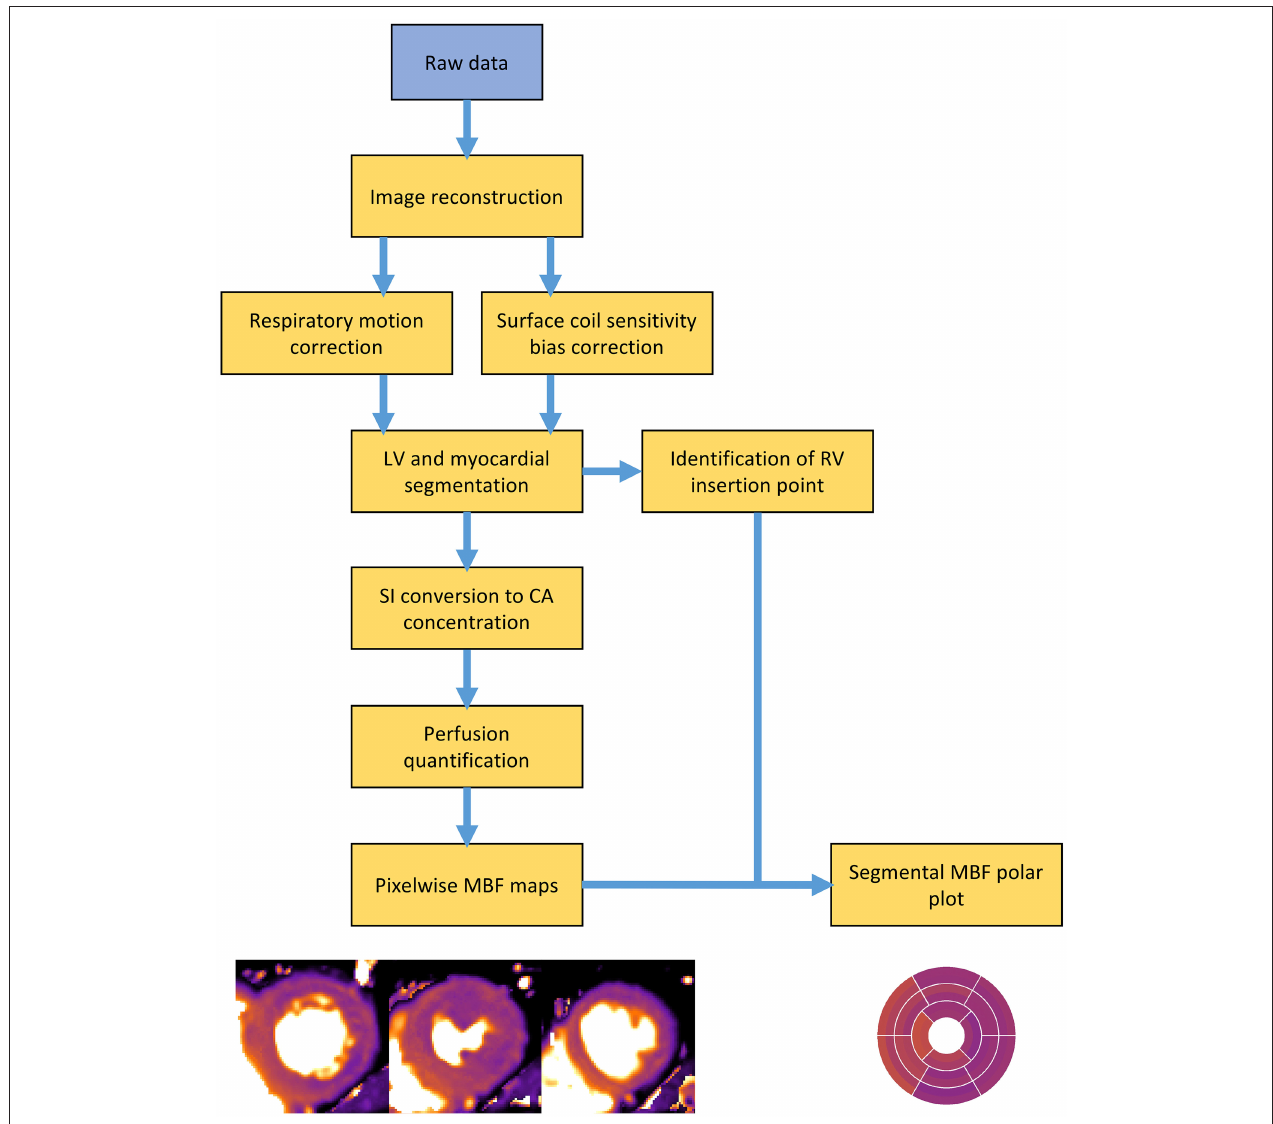
FIGURE 4 | Overview schematic outlining the processing steps involved in a typical perfusion quantification pipeline. LV, left ventricle; RV, right ventricle; SI, signal intensity; CA, contrast agent; MBF, myocardial blood flow.